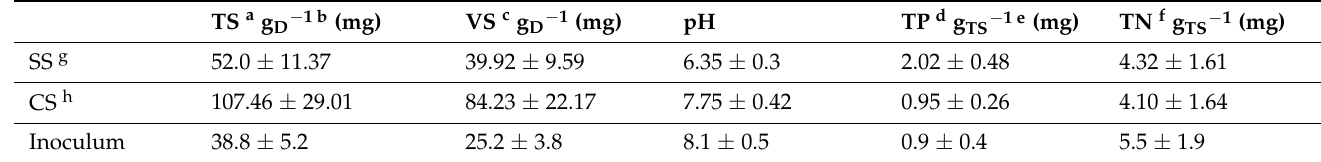
Table 1. Characteristics of the substrates and the inoculum used in the AD process.